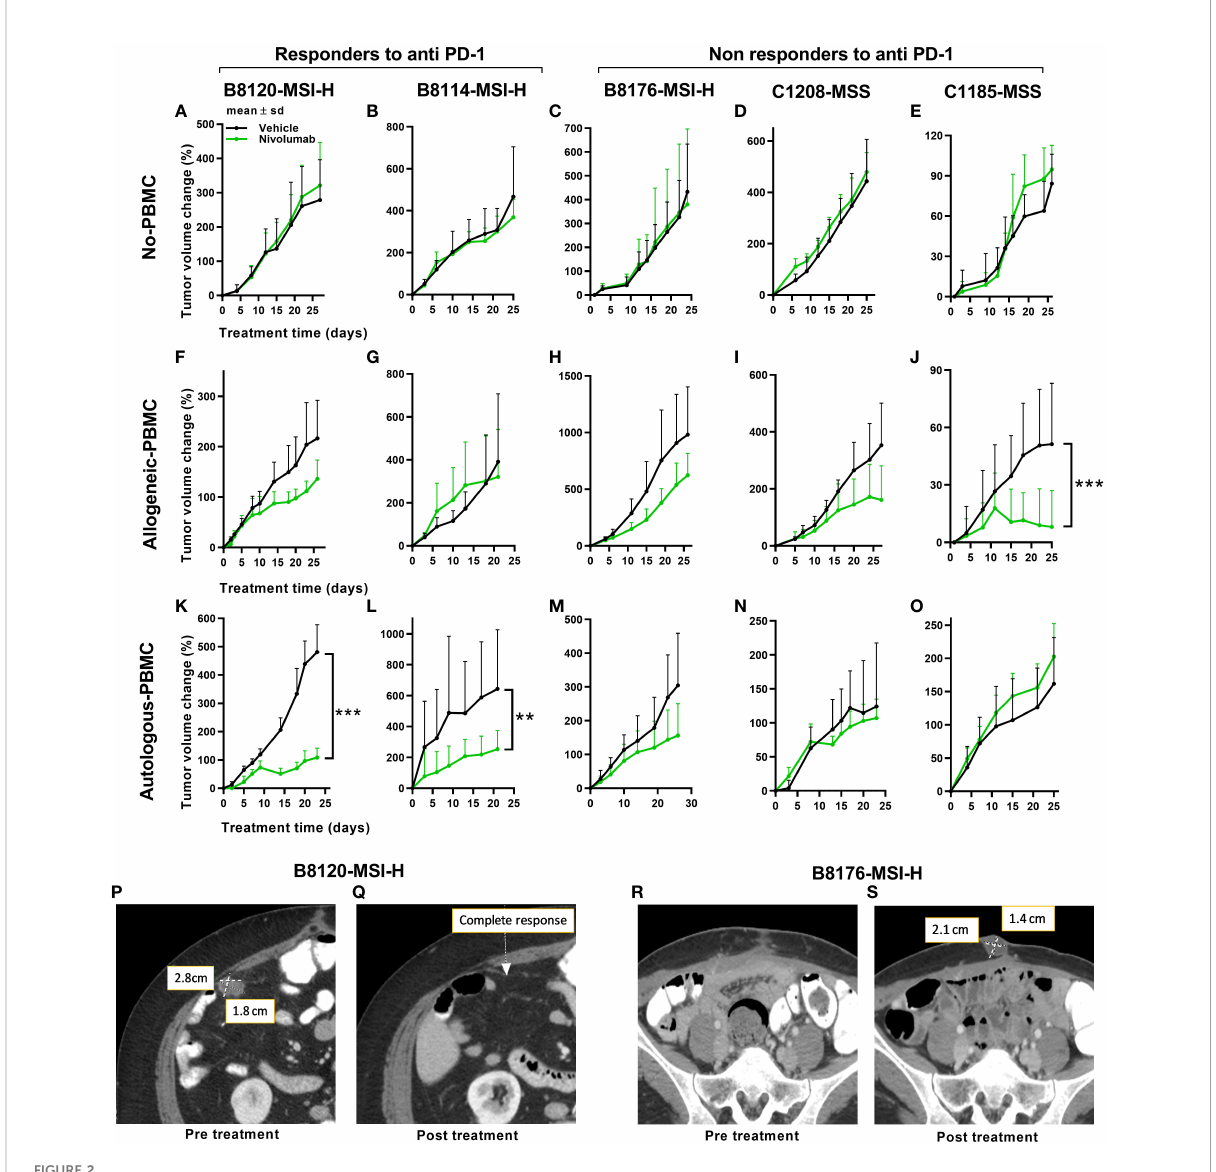
FIGURE 2 Tumor responses to anti-PD-1 therapy under non-humanized, allogeneic, and autologous conditions. Tumor volume change [ D V % =100*(V t -V 0 )/ V 0 ] plots are shown here. (A – E) Results of anti-PD-1 therapy for fi ve PDXs under non-humanized conditions (n=6-9 tumors/arm). (F – J) Results of anti-PD-1 therapy for fi ve PDXs under allogeneic conditions (n=6-9 tumors/arm). (K – O) Results of anti-PD-1 therapy for fi ve PDXs under autologous condition (n=6-9 tumors/arm). The green lines and dots represent treatment with nivolumab at 20mpk Q5D. (P, Q) Scans of the patient corresponding to the B8120 model before (P) and after (Q) immune checkpoint therapy. (R, S) Scans of the patient corresponding to the B8176 model before (P) and after (Q) immune checkpoint therapy. P values ≤ 0.001 were represented as ***. and P values ≤ 0.01 were represented as